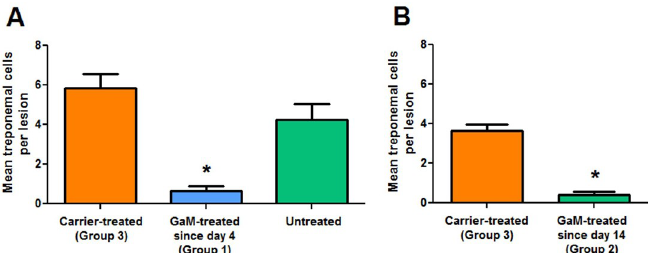
Fig 3. DFM analysis of lesion aspirates. Panel A shows pathogen burden at day 13 post-infection in Group 1 animals (treated with GaM since day 4 post-infection) compared to carrier-treated animals (Group 3) and untreated animals (which started treatment the following day and were then identified as Group 2). The untreated animals started GaM treatment on day 14 post-infection. Panel B shows pathogen burden at day 23 post-infection in Group 2 animals (treated with GaM since day 14 post-infection) compared to carrier-treated controls (Group 3). Asterisks indicate statistical significance (p <